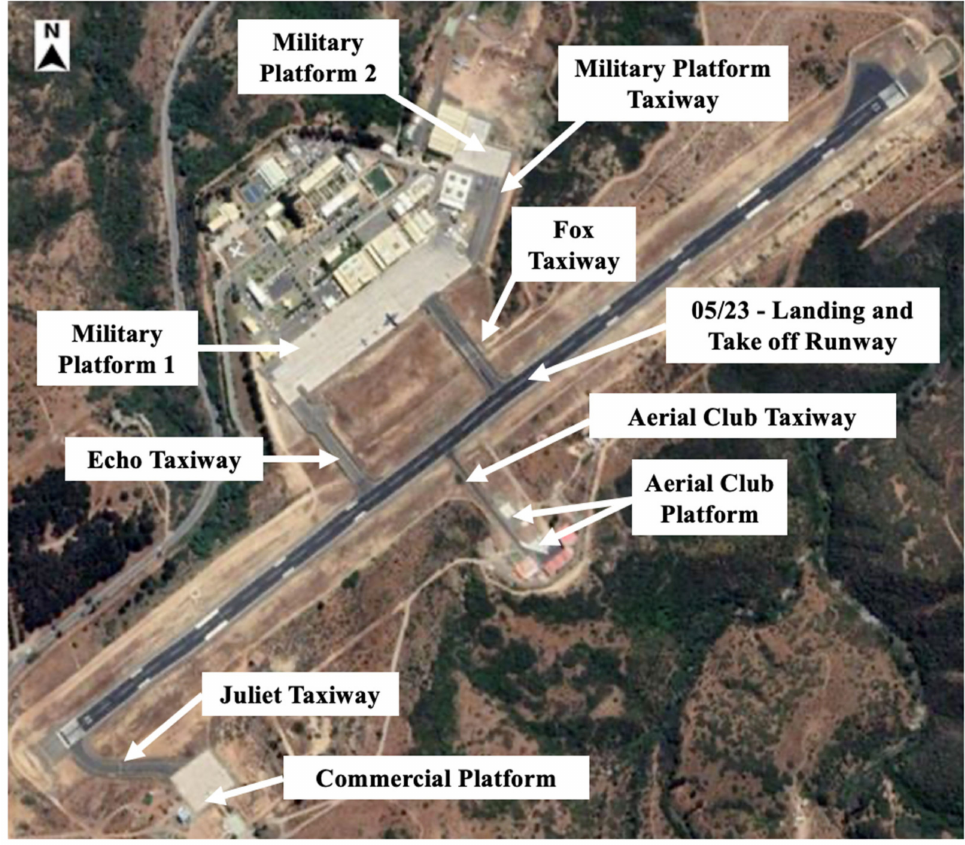
Figure 2. Taxiways and platforms of the Viña del Mar Airport. Table 1. Summary table geometry and materiality of the Viña del Mar Airport movement